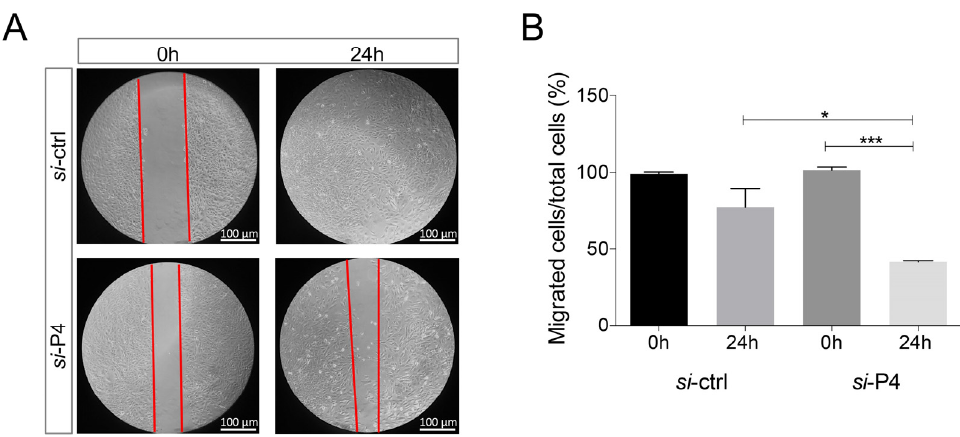
Figure 5. PA2G4P4 silencing e ff ects on J82 bladder cancer migration. ( A ) Representative views of the wound healing assay were captured at 0 and 24 h, demonstrating a reduced migration of J82 cells following pseudogene silencing, as compared to the control. The scale bar in the image is 100 µ m. Magnification 10X. ( B ) Quantification of cell migration by measuring the distance between the invading front of the cells in three randomly selected microscopic fields (magnification, x20) for each condition and time point. The degree of motility is expressed as the percentage of wound closure, as compared with the 0-time point. PA2G4P4, proliferation-associated 2G4 pseudogene 4. (*** p < 0.001,* p < 0.05).